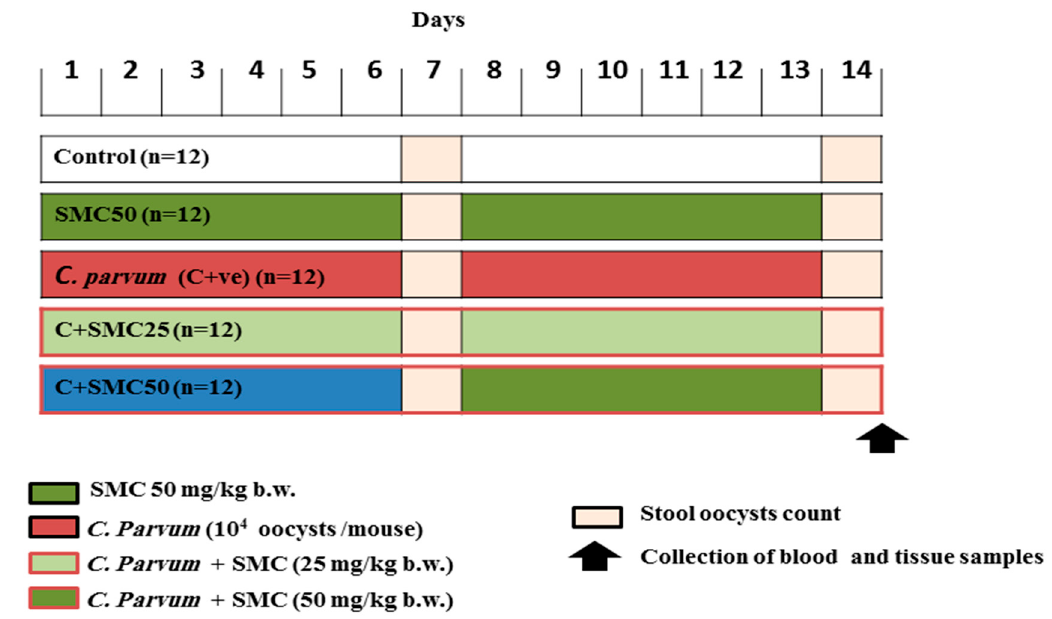
Figure 1. Treatment protocol and doses of used s-Methylcysteine (SMC).